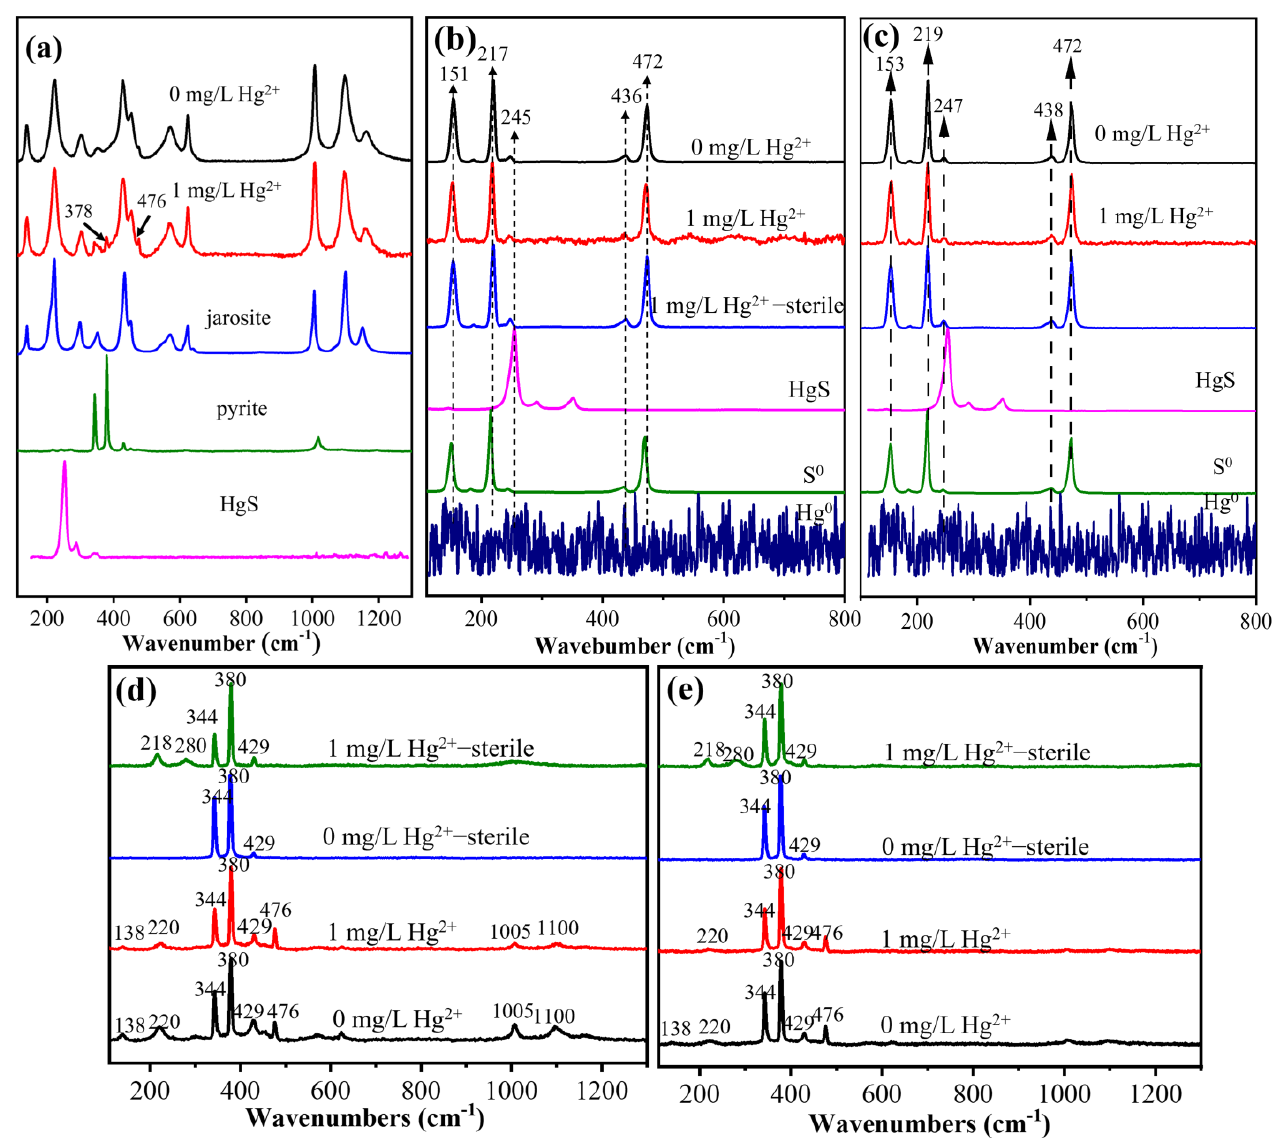
Figure 7. Raman images of bacterial cells of A. ferrooxidans ATCC 23270 in the presence of Hg 2+ . ( a ) Fe 2+ oxidation; ( b ) S 0 oxidation; ( c ) anaerobic Fe 3+ reduction coupled with S 0 oxidation; ( d ) the aer-